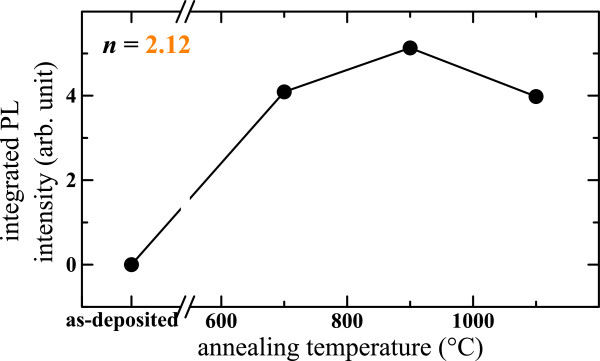
Evolution of the integrated PL intensity with the annealing temperature.